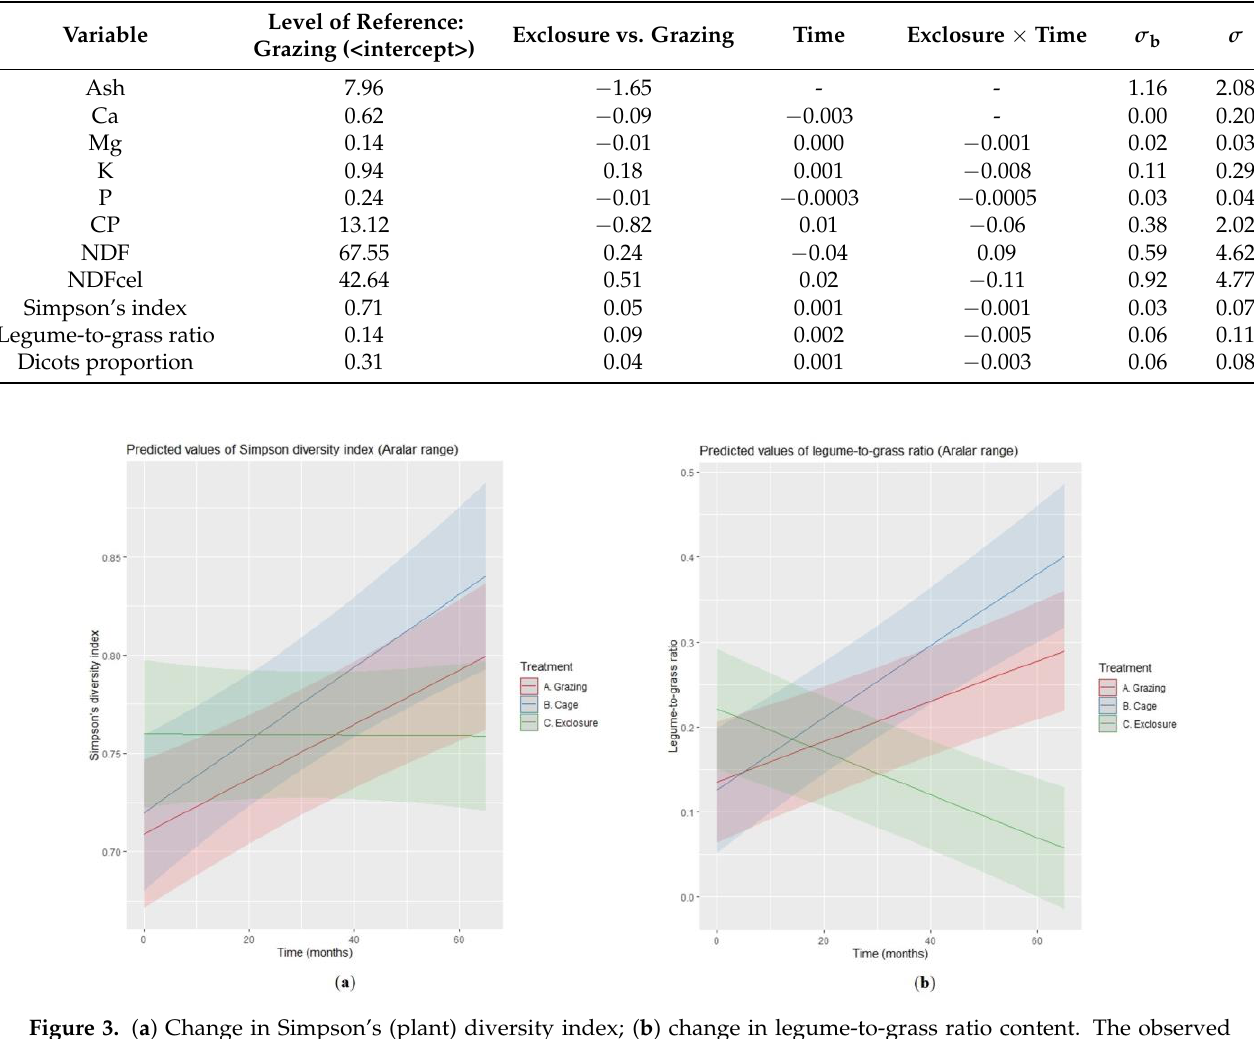
Figure 4. Direct (paths from X to Y ) and indirect effects (paths from X to Y passing through M ) of experimental grazing exclusion ( X ) on descriptors of forage nutritive quality ( Y ), once that topsoil properties ( Z ) have been taken into account. ( a ) Simultaneous change in the legume-to-grass ratio mediates 80% of change in crude protein content and, ( b ) 55% of change in enzymatic digestibility; ( c ) concurrent change in the proportion of dicots mediates 31% of change in cation calcium forage content.